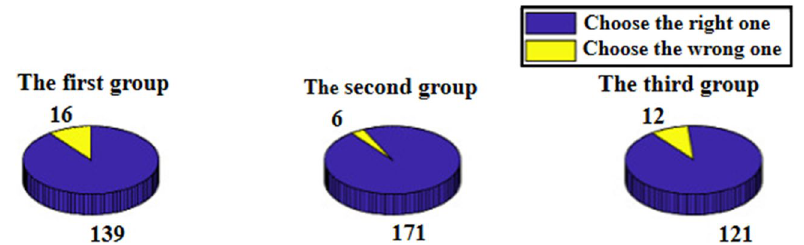
Figure 1. Statistics of the number of decision-makers, and the results in Questionnaire 1.